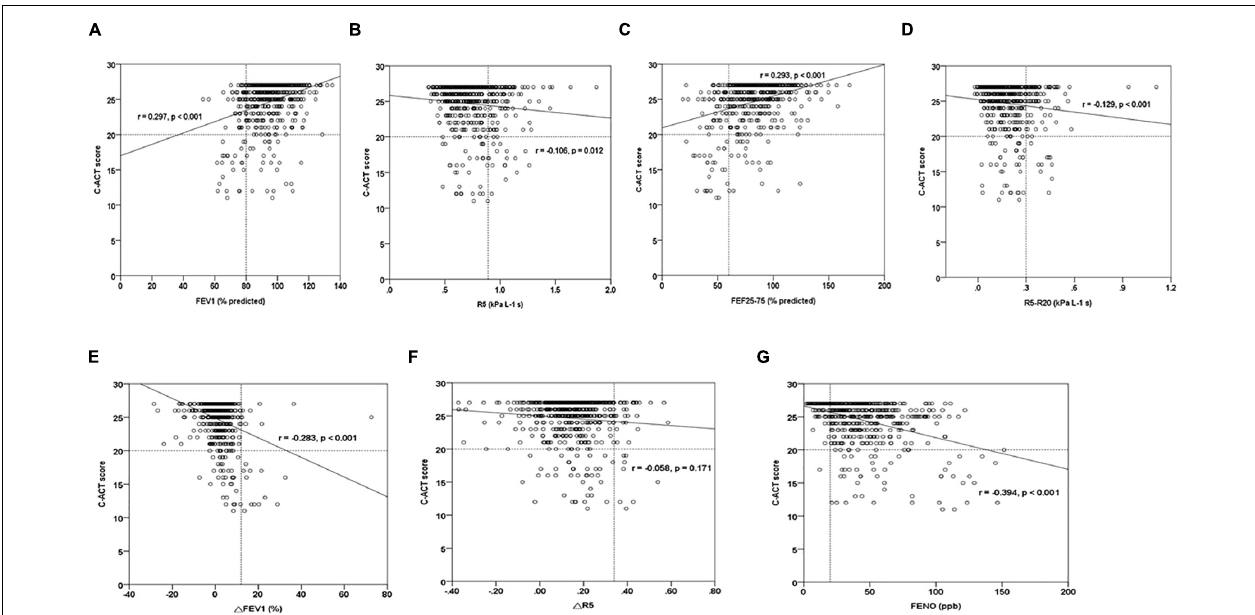
FIGURE 2 | The graph of the C-ACT score relationships among FeNO, spirometry, and IOS parameters in asthmatic children. (A,B) C-ACT scores vs. obstructive airway disease parameters (FEV1, R5), (C,D) C-ACT scores vs. small airway disease parameters (FEF 25 - 75 , R5-R20), (E,F) C-ACT scores vs. bronchodilator response parameters ( (cid:77) R5, (cid:77) FEV1), (G) C-ACT scores vs. FeNO. r , Spearman’s rho correlation